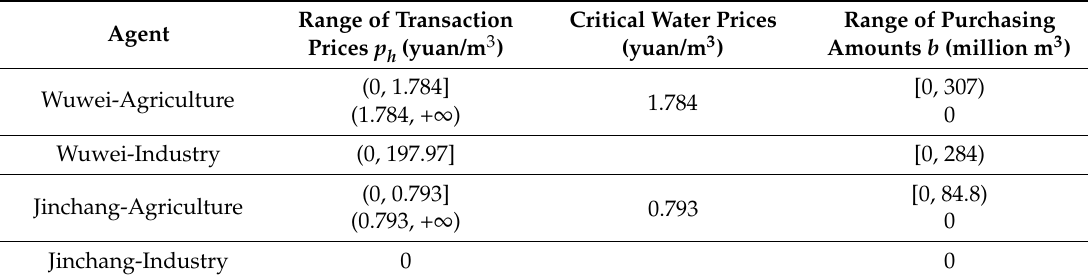
Table 13. Range of quotations and purchasing amounts of each agent in 2020.